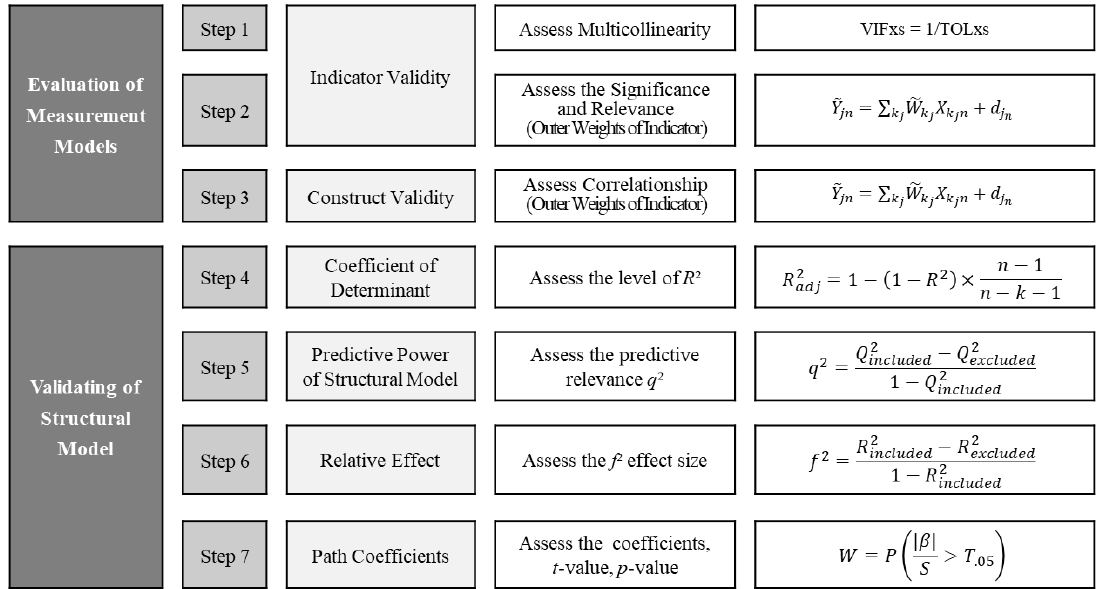
Figure 6. Assessment procedure of the formative measurement model (Step 7). Adapted from [59] and [62].